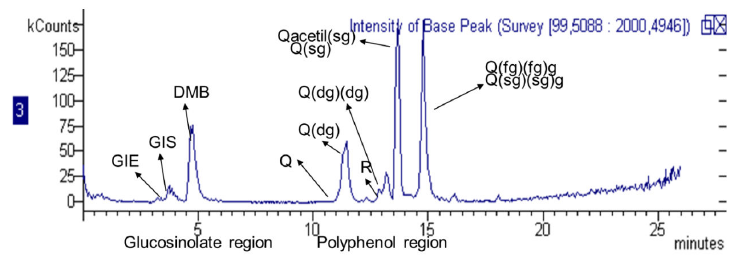
Figure 1. LC/ESI-MS chromatogram of the Eruca extract from freeze-dried rocket leaves. Abbreviations of compounds are indicated in Tables 1 and 2.